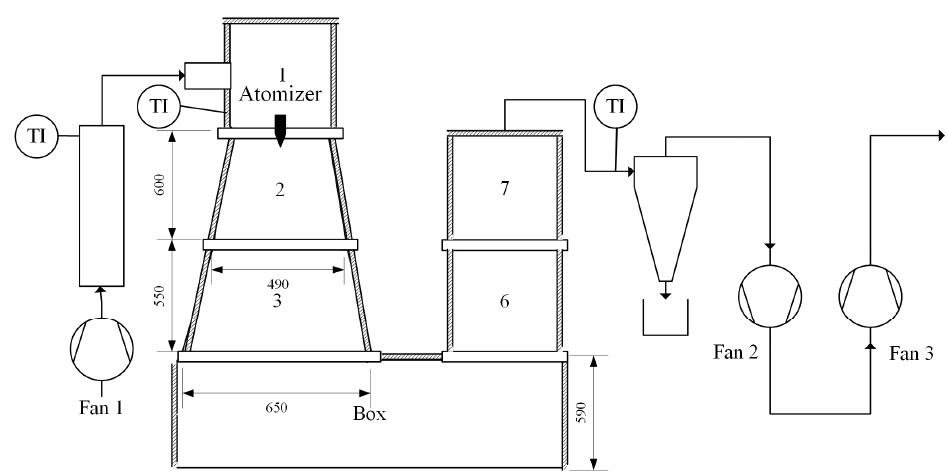
Figure 2. Spray dryer with cylindrical drying chamber and box connection (Design 3) [22].